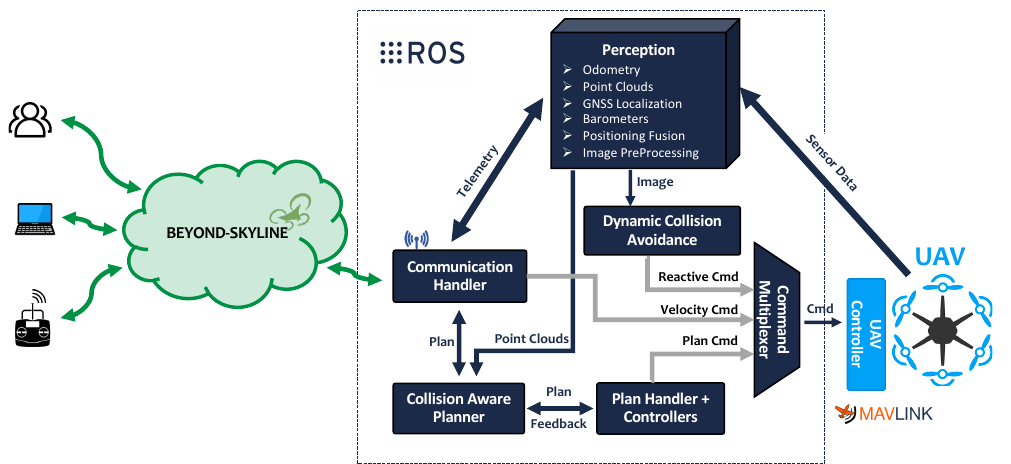
Figure 2. Architecture of the framework for fully autonomous Unmanned Aerial Vehicles